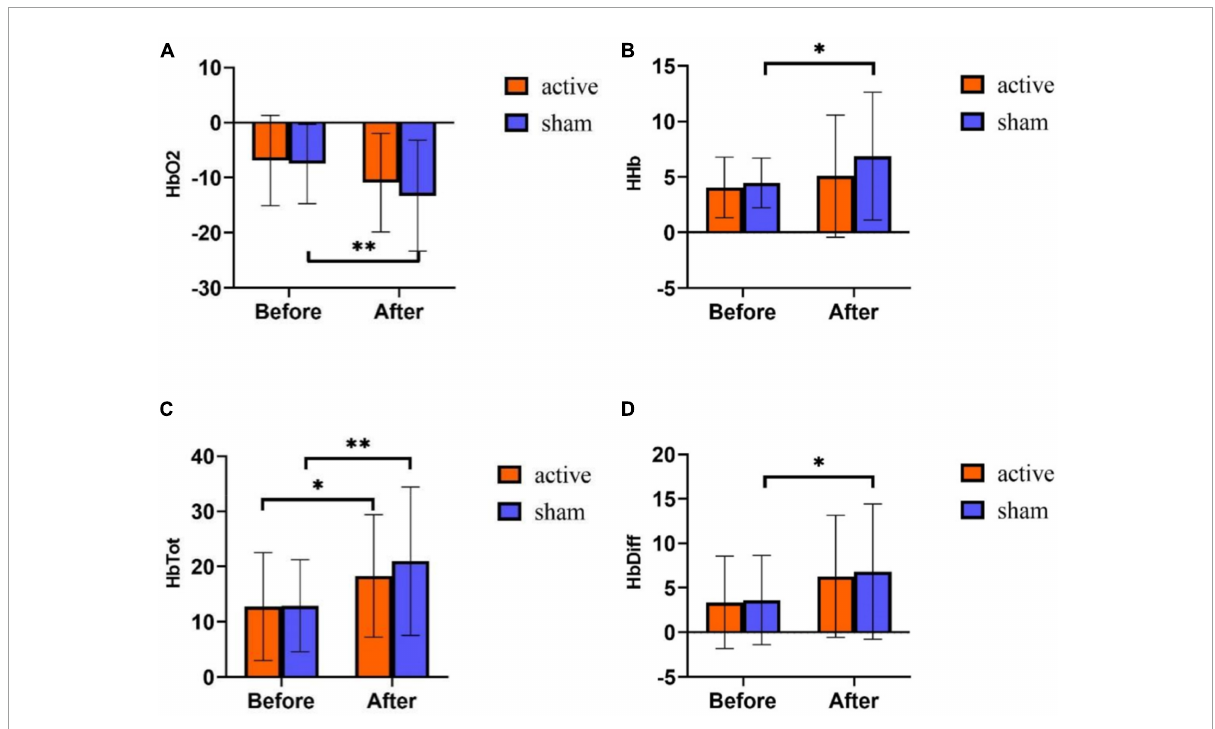
FIGURE5 fNIRS results of tPCS on athletic mental fatigue. (A) Oxyhemoglobin (HbO 2 ); (B) deoxyhemoglobin (HHb); (C) total hemoglobin (HbTot); (D) hemoglobin difference (HbDiff). ∗ p < 0.05, ∗∗ p <